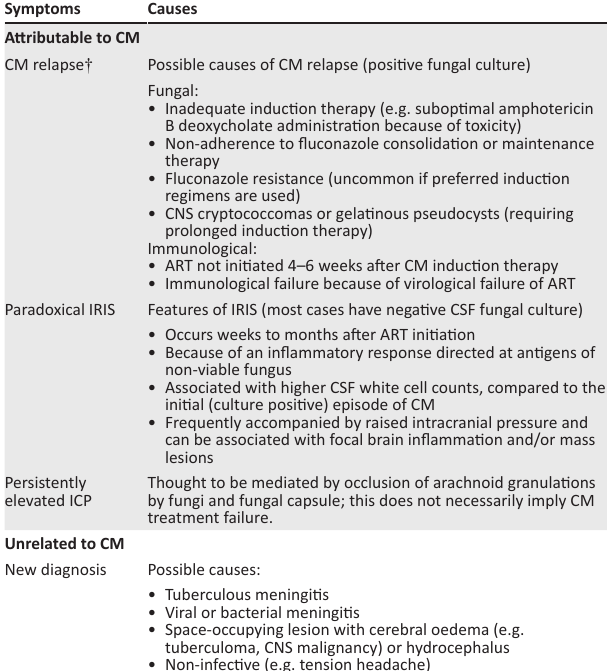
TABLE 10: Possible causes of recurrent symptoms and signs of meningitis in cryptococcal